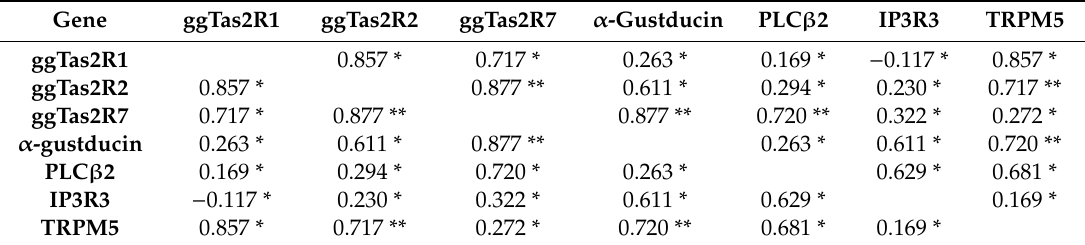
Table 2. Correlation analysis of bitter taste and downstream signaling e ff ectors related genes in the heart of